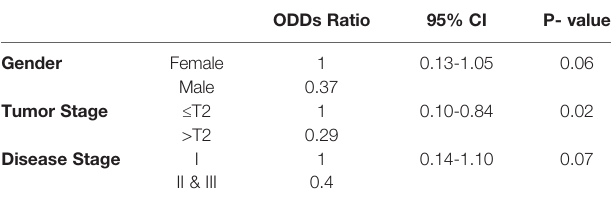
TABLE 2 | Association of tumor and disease stage with STIL